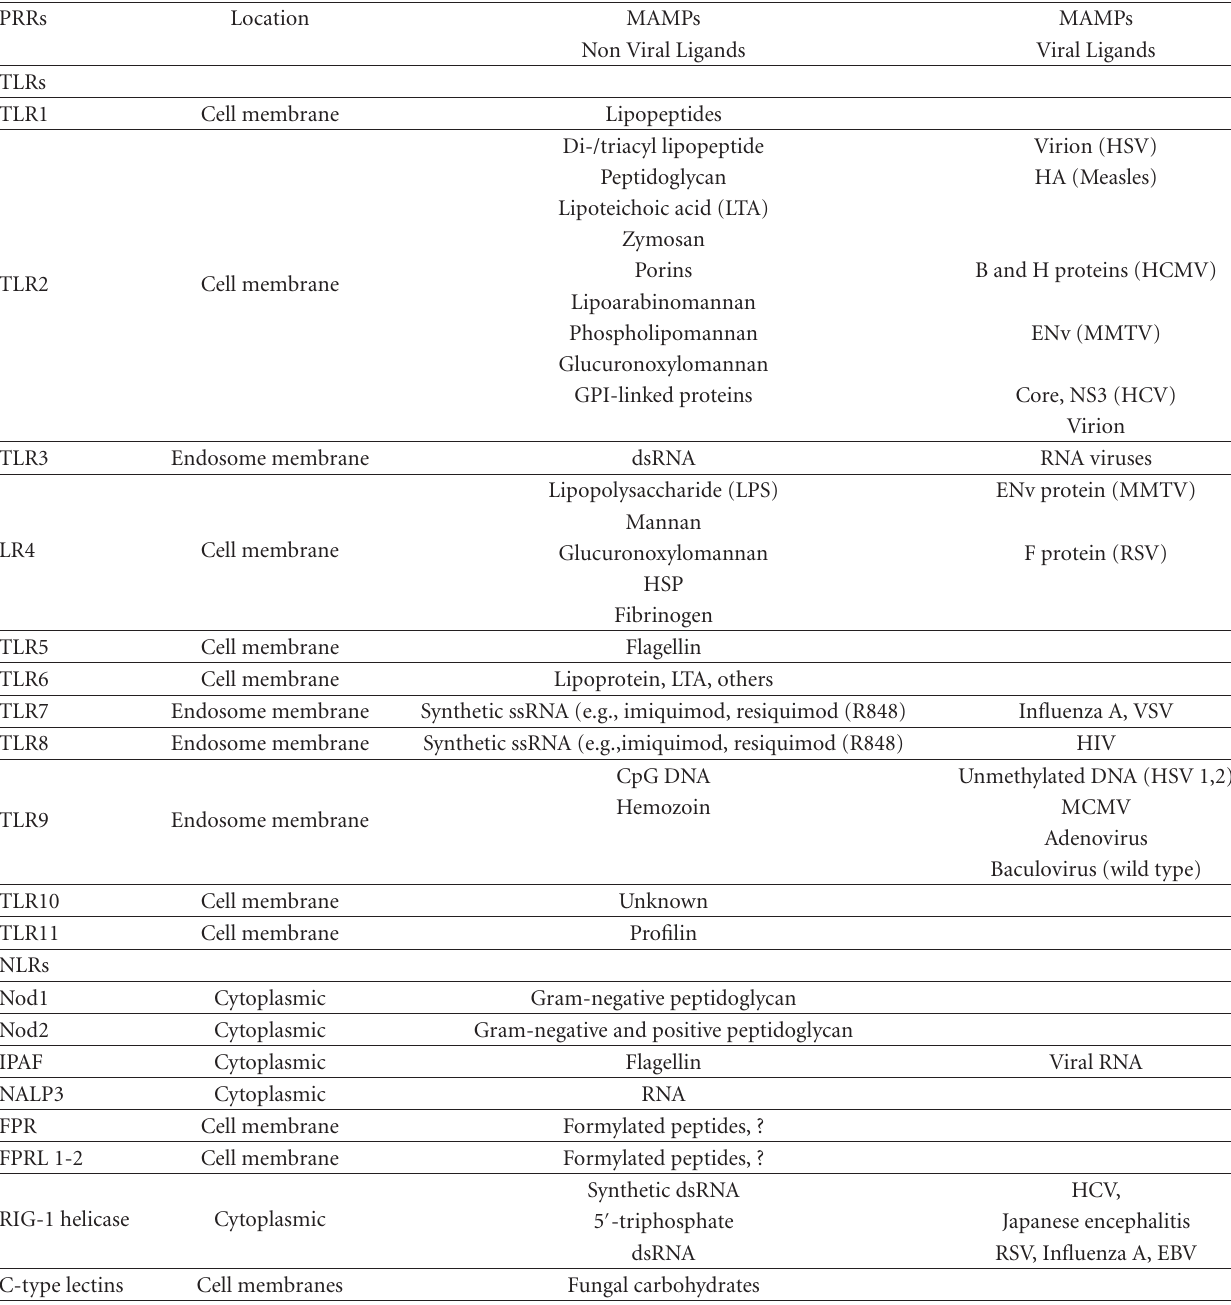
Table 1: Pattern recognition receptors (PRRs), microbial-associated molecular patterns (MAMPs), and expression patterns (see, [3, 12, 14]). PRRs